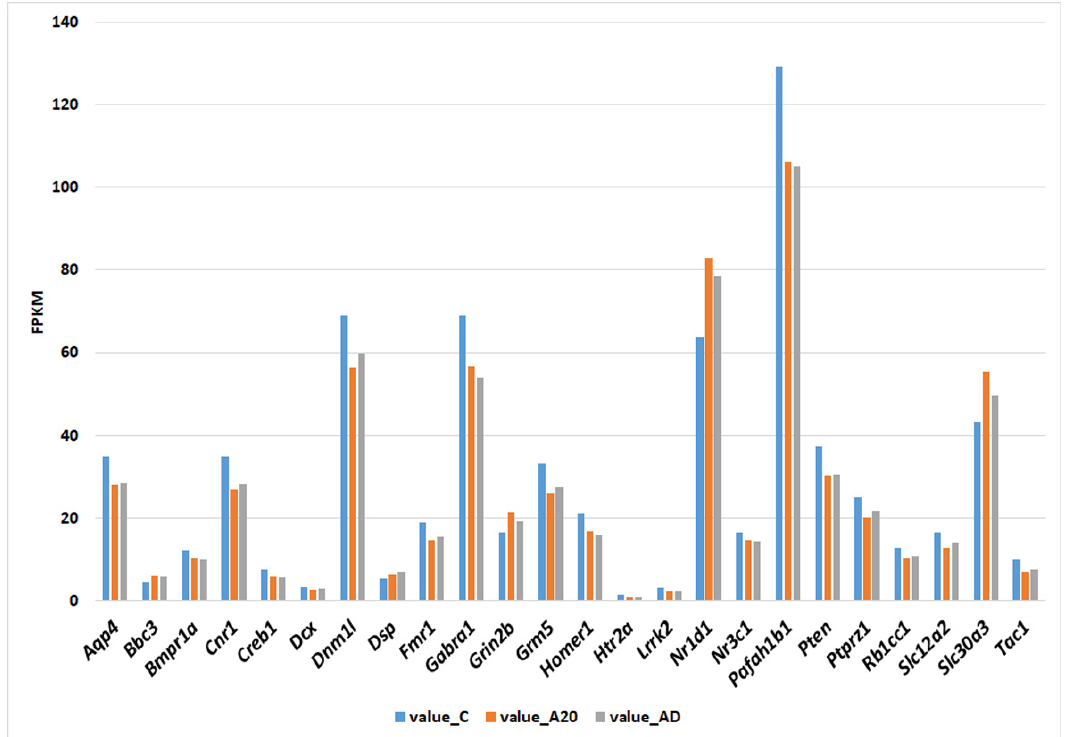
Figure 6. Genes that significantly changed their levels of transcription during the period of agonistic interactions (C_A20 DEGs), whose expression did not get restored during the fighting deprivation (C_AD differences are statistically significant). FPKM, fragments per kilobase of transcript per million mapped reads; value C: expression in control mice (no experience of agonistic interactions); value_A20: expression in males with consecutive 20 days of wins in daily agonistic interactions; value_AD: expression in males with consecutive 20 days of wins in daily agonistic interactions deprived of fighting for 14 days.